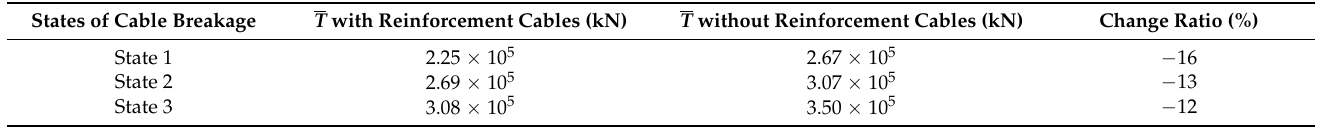
Table 2. Comparison of mean cable tension response with or without reinforcement